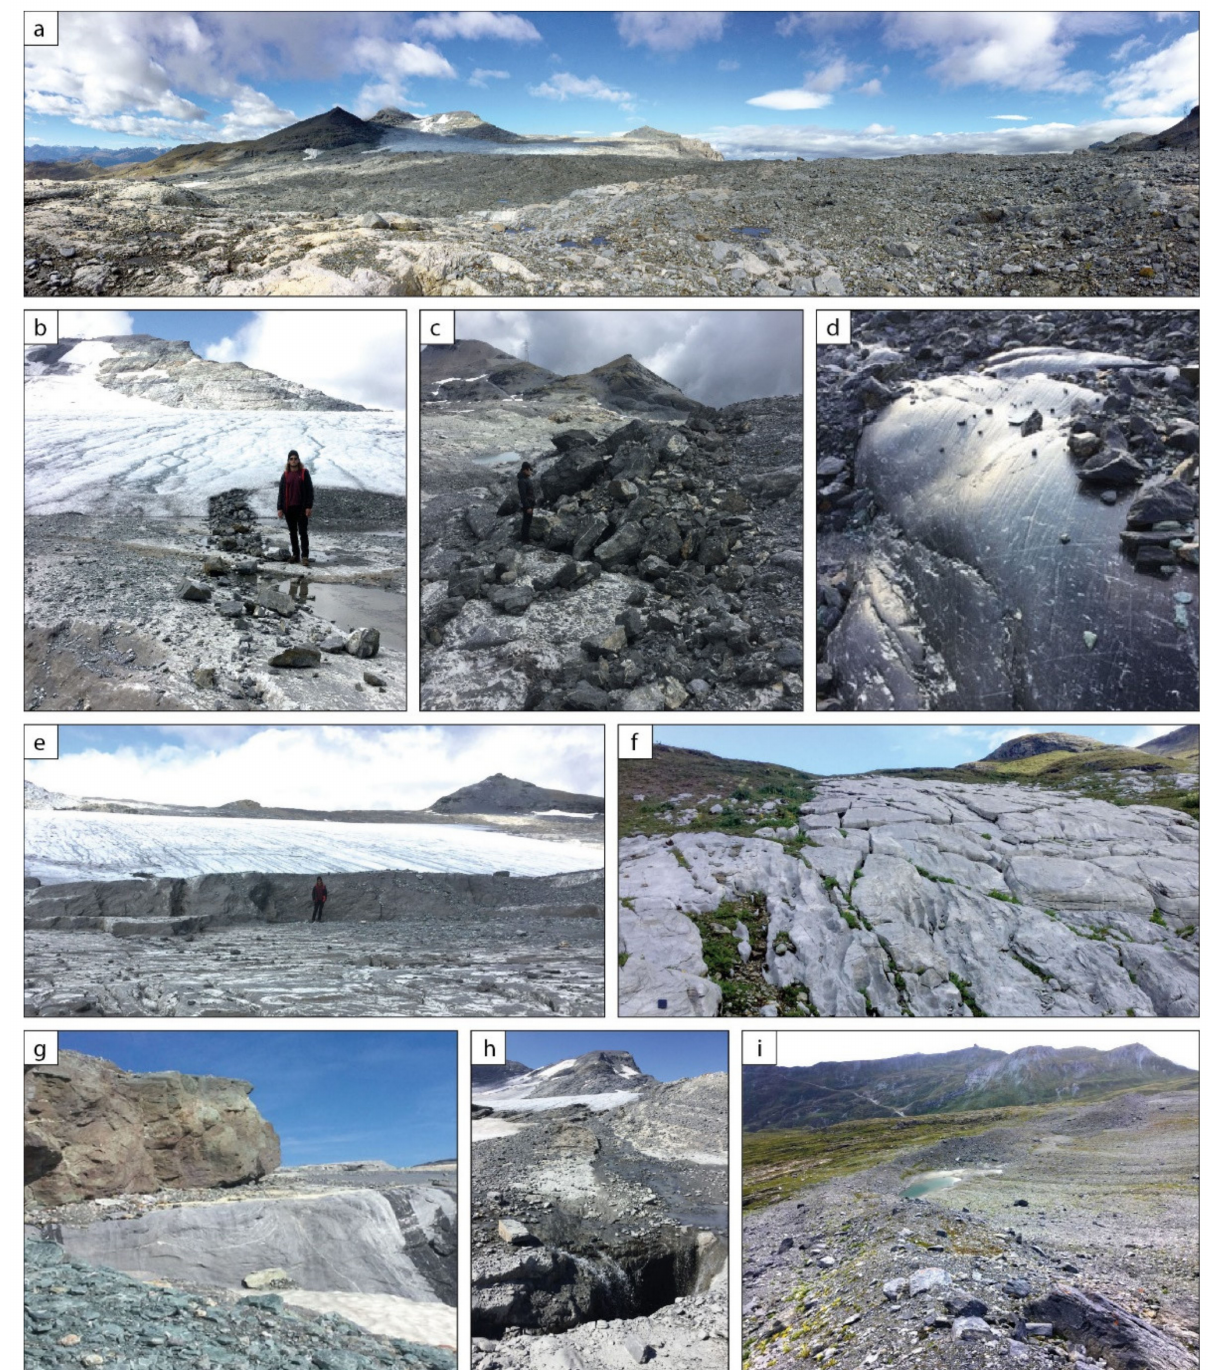
Figure 5. Photo panel, location of each photo and view direction is shown on Figure 3. ( a ) View across the flat limestone forefield of the Vorab glacier (in the background). Note the sparse sediment cover. ( b ) Sediment stripe with small clasts emerging englacially. ( c ) Sediment stripe with large clasts, see person for scale. ( d ) Polished and striated bedrock. ( e ) Bedrock step in front of the Vorab glacier, see person for scale. ( f ) Strongly karstified bedrock with deep channels and karren outside of the LIA extent. ( g ) Glarus thrust with Verrucano (phyllites) on top of Lower Cretaceous limestone. ( h ) Swallow hole where glacial meltwater disappears into the karst system. ( i ) LIA moraine